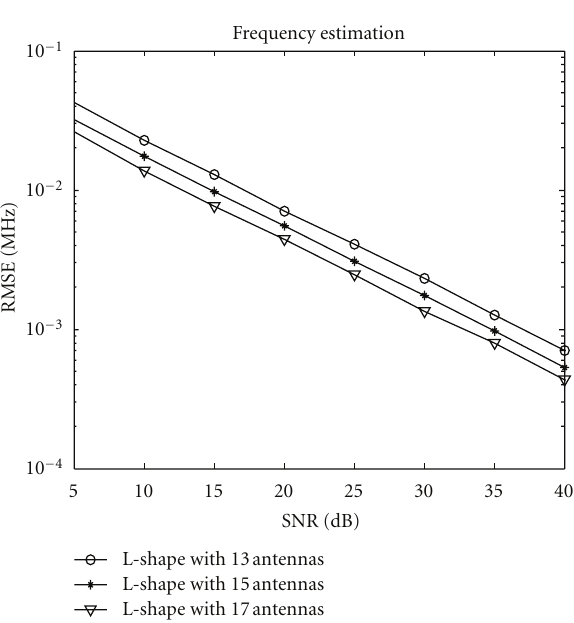
Figure 6: Frequency estimation performance comparison.